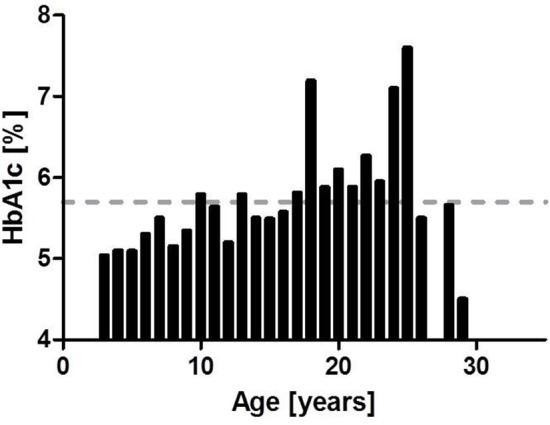
HbA1c (n = 3) and age. As depicted here HbA1c is increasing with age. Normal range is up to 5.7% (hatched line).